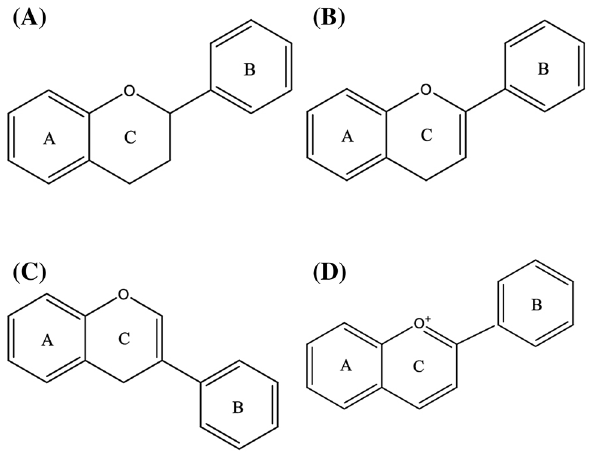
Fig. 1 The basic scaffolds of flavonoids. a The scaffold of flavanones and catechins; b the scaffold of the flavones and flavonols; c the scaf- fold of isoflavone; d the scaffold of anthocyanins. The structures of aurones and biflavones were not involved in this figure since their structures containing some special elements which were described in the article